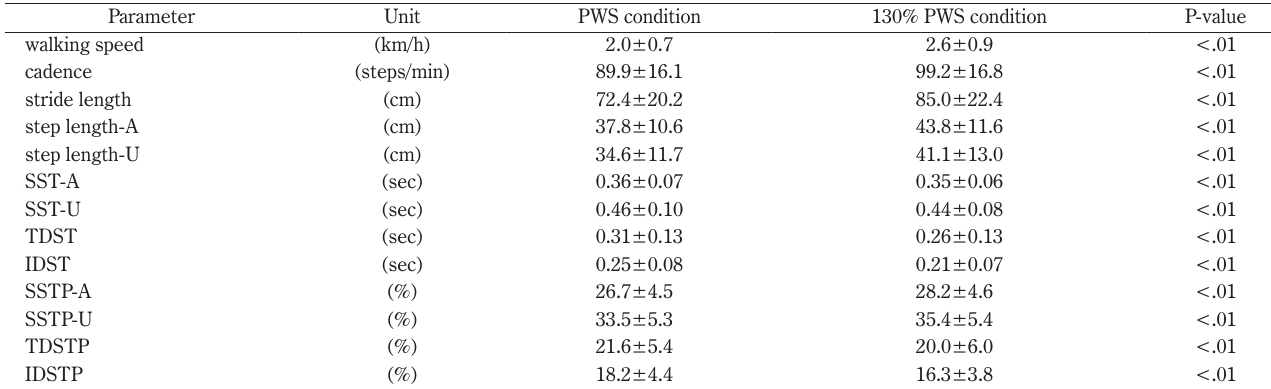
Table 2 Time-distance parameters at PWS condition and 130% PWS condition